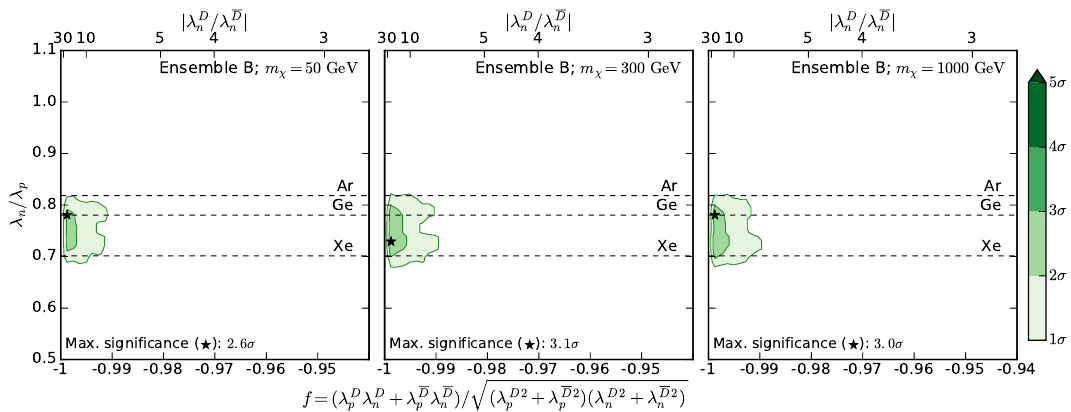
Figure 2 . Median signi(cid:12)cance for discriminating Dirac from Majorana DM using ensemble B (Xe + Ar + Ge). As (cid:12)gure 1, but for ensemble